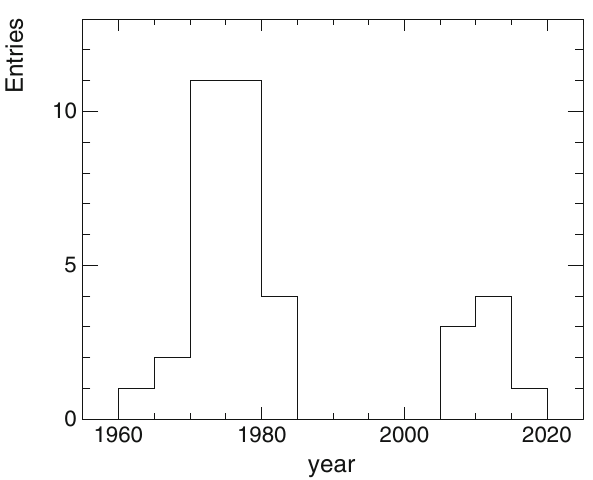
Fig. 3 Time distribution of published results on π − production in the range of p T < 1 . 3